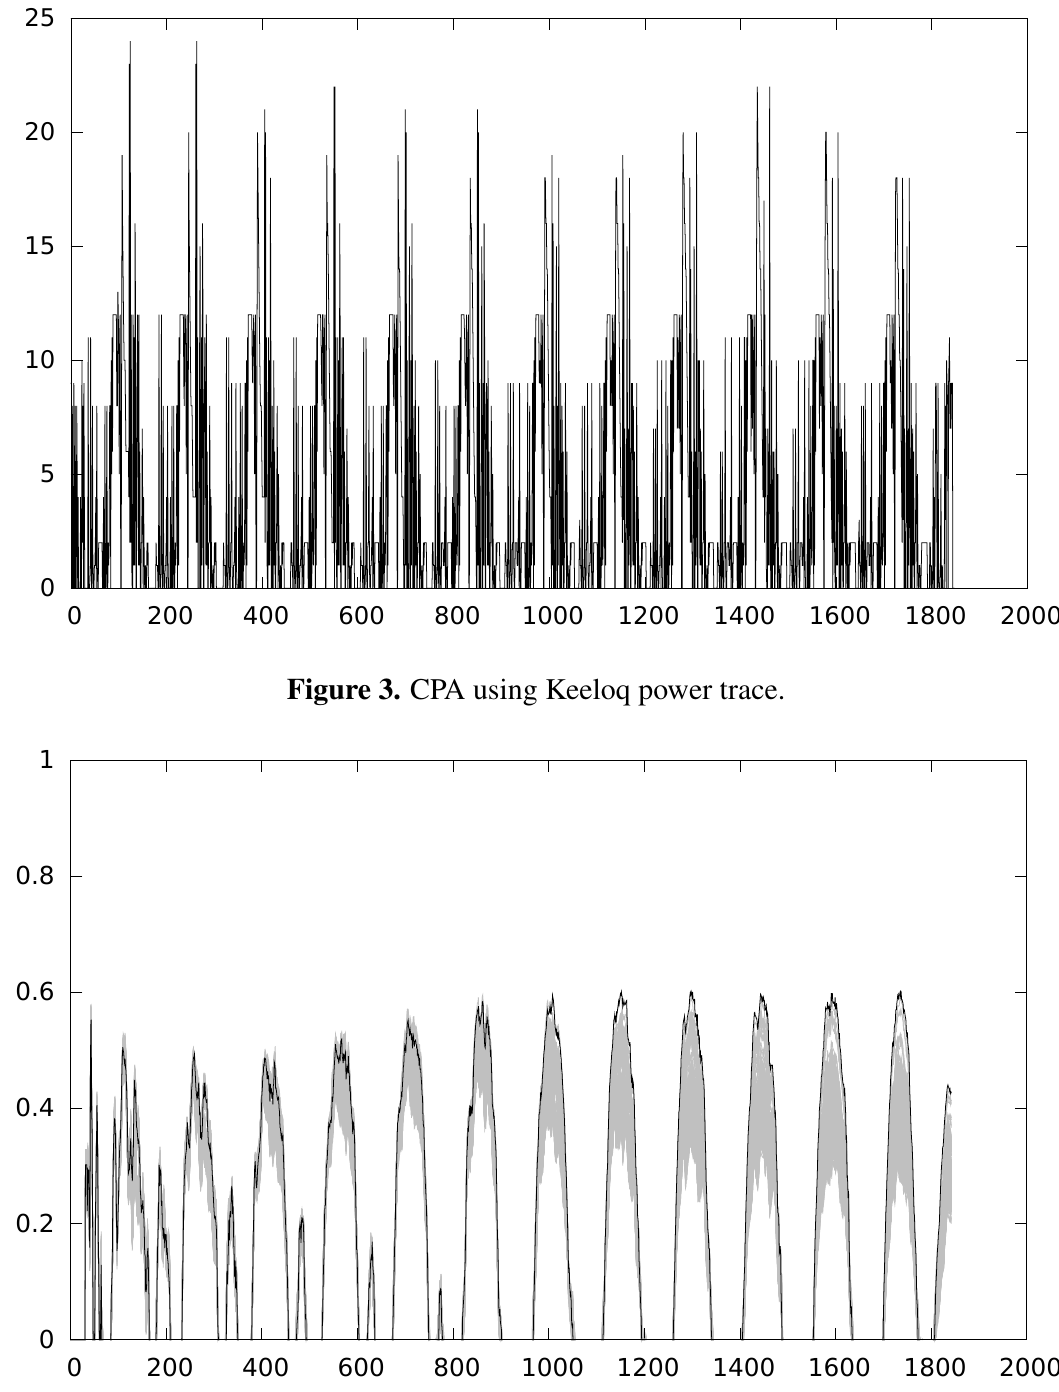
Figure 2. Keeloq power trace (first 12 rounds).